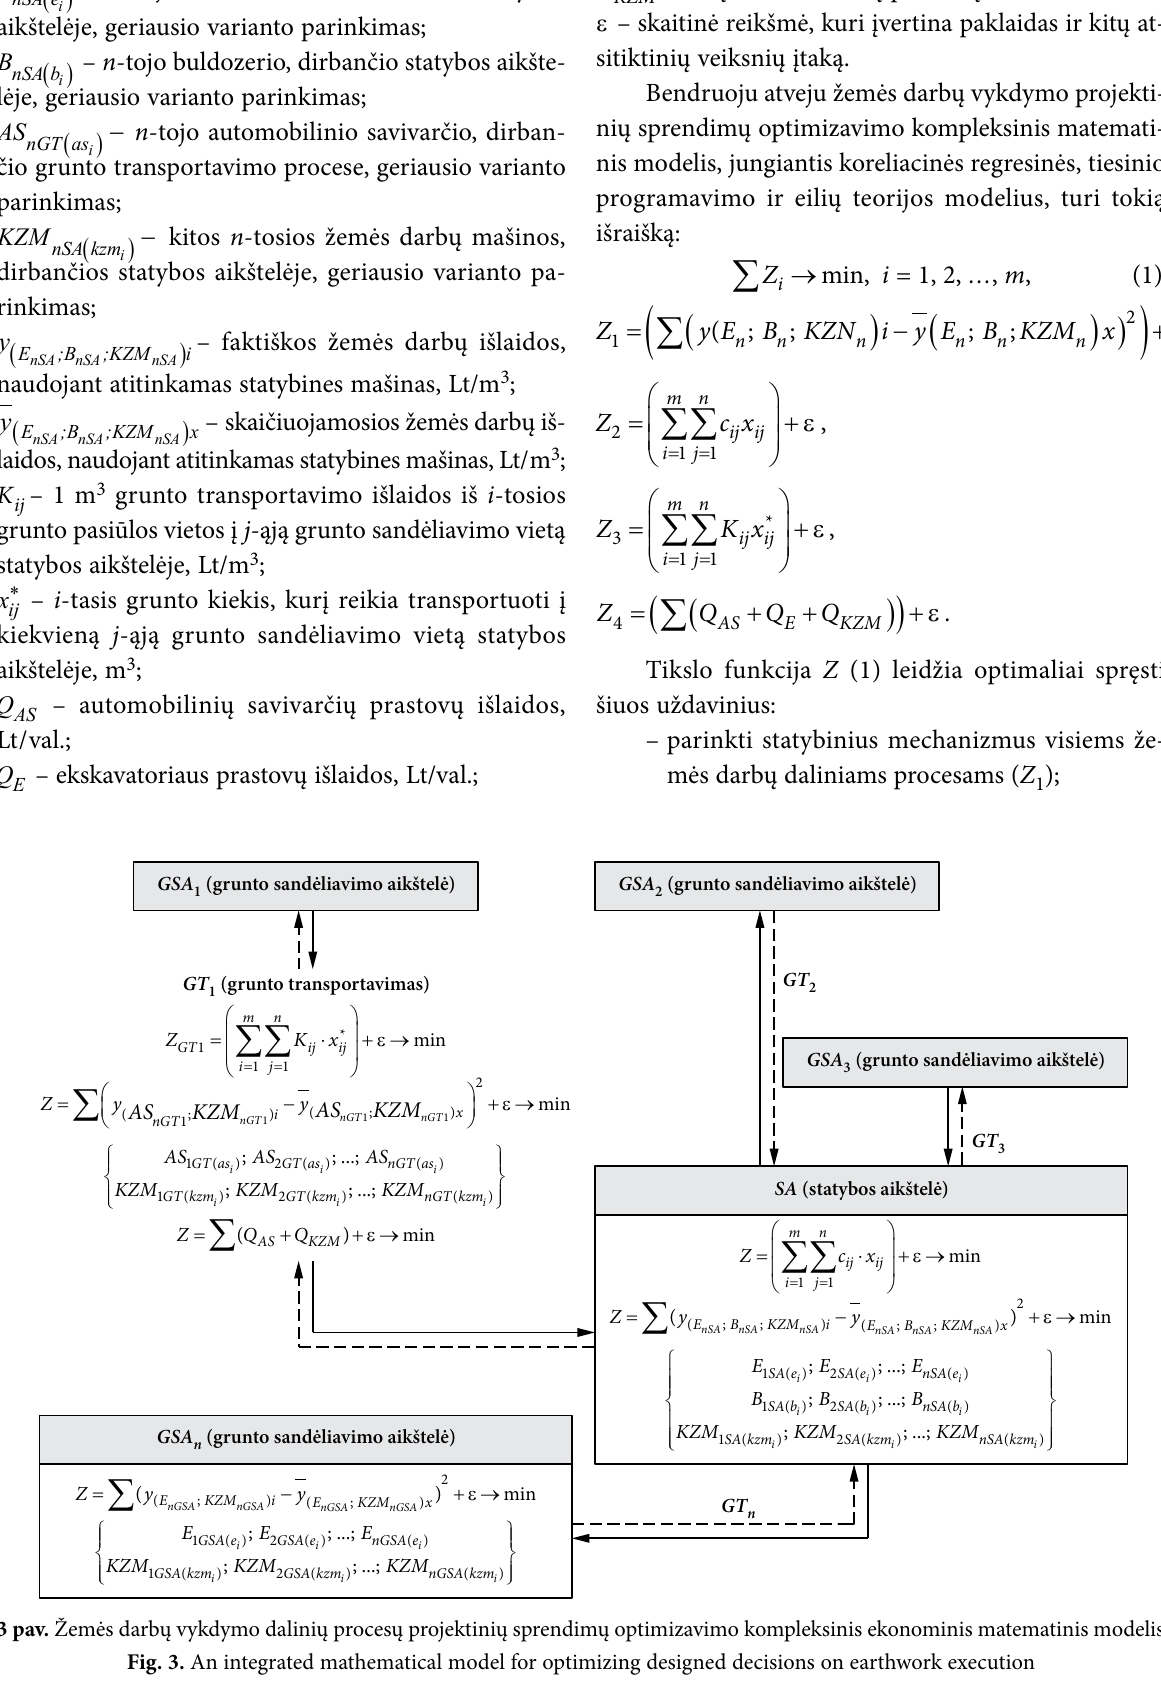
Fig. 3. An integrated mathematical model for optimizing designed decisions on earthwork